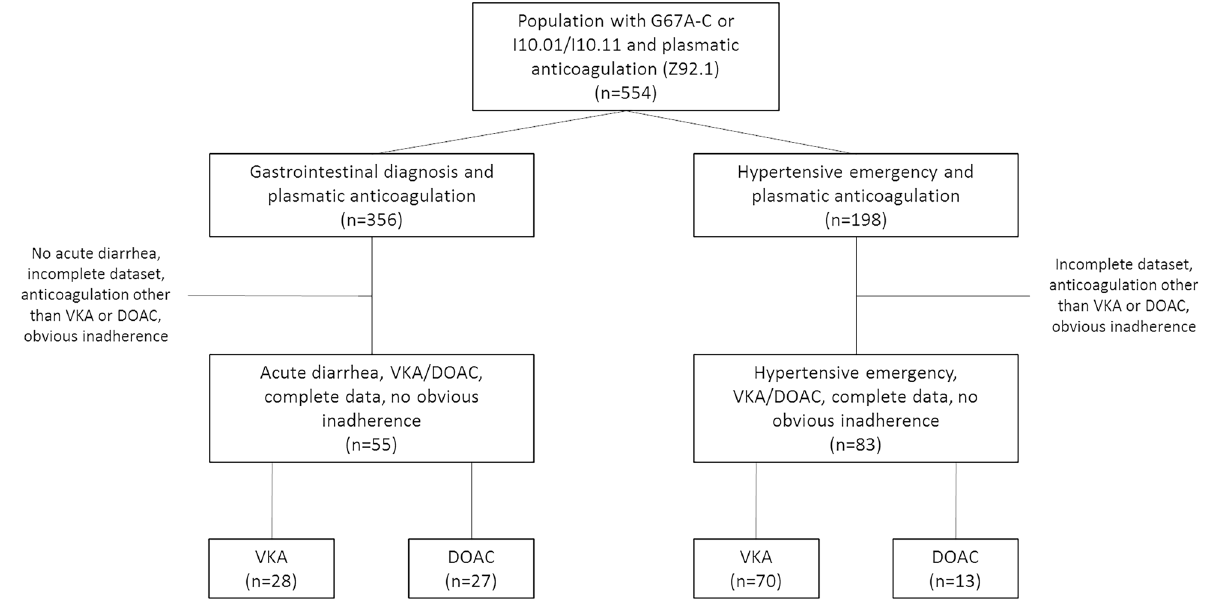
Figure 1. Study population.